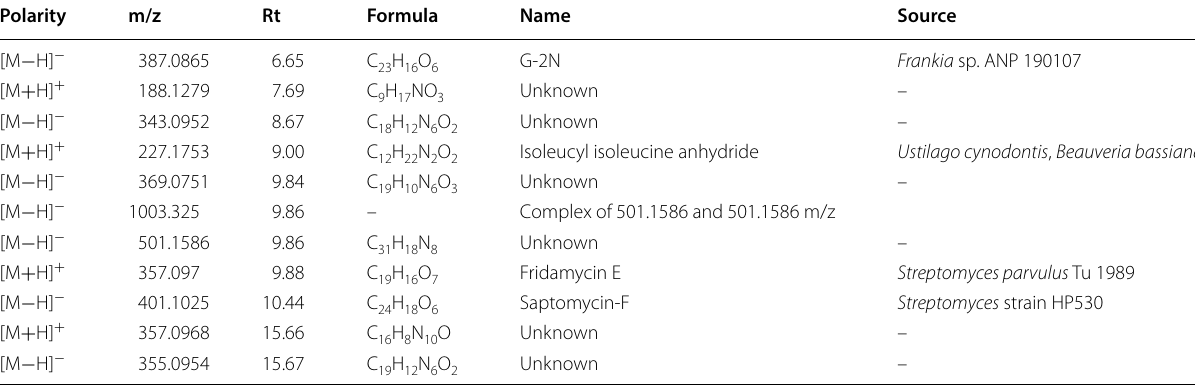
Table 1 The dereplication results of the active fractions against DNP database Polarity m/z